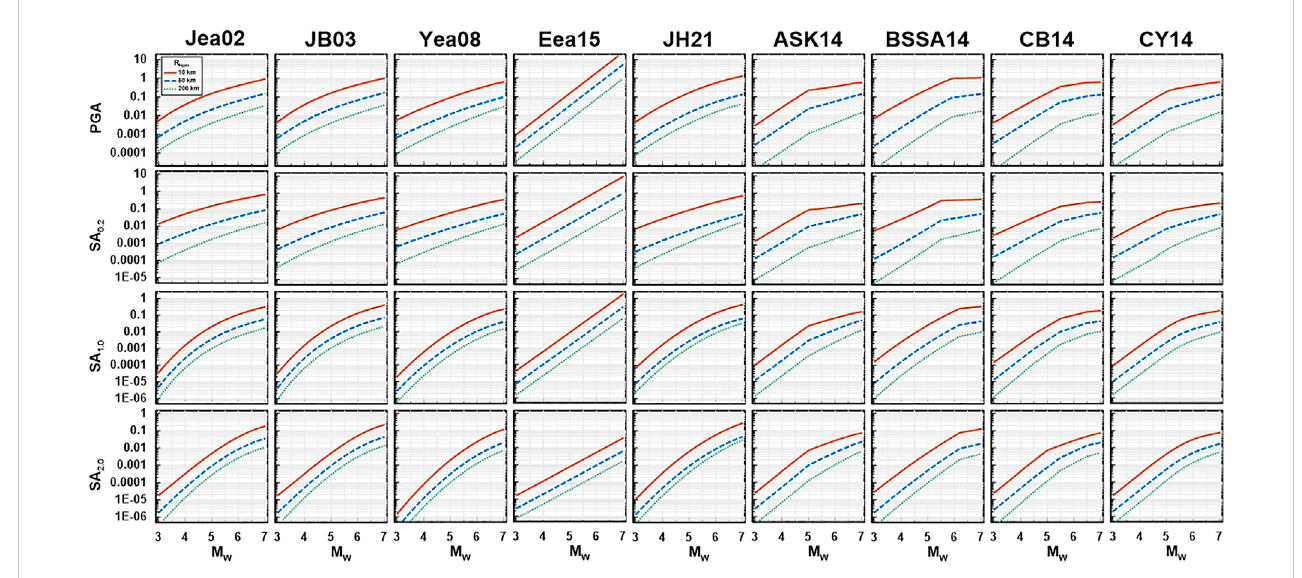
FIGURE 3 Comparison of fi ve Korean GMMs (Jea02, JB03, Yea08, Eea15, and JH21) and four global GMMs (ASK14, BSSA14, CB14, and CY14) for PGA, SA 0.2 , SA 1.0 , and SA 2.0 with varying M W at R hypo =10, 50, and 200 km.